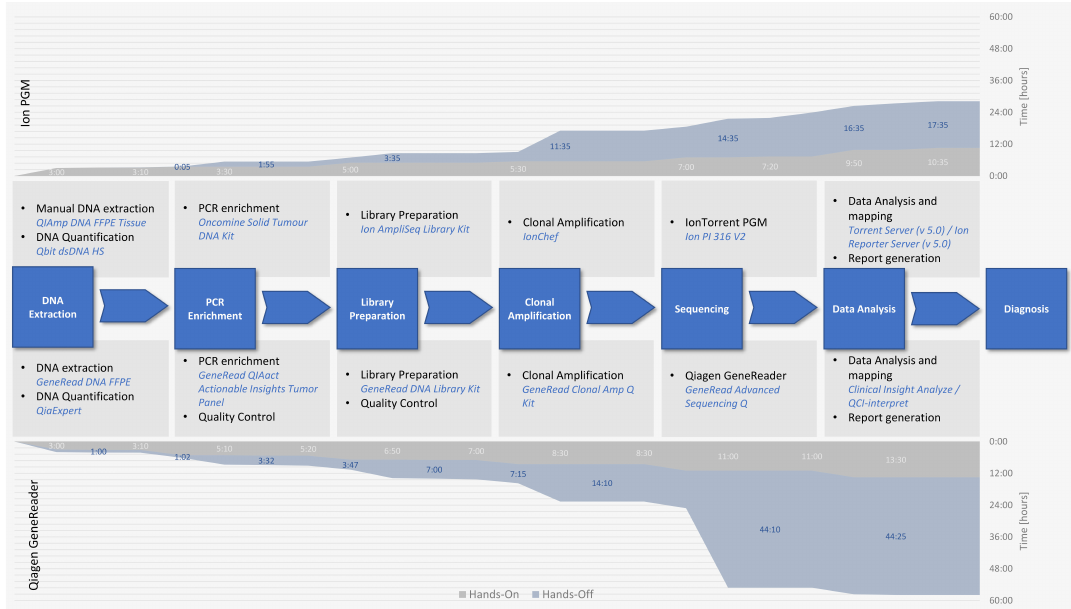
Figure 2. Comparison of the workflow and the different times needed for the Ion PGM workflow in contrast to the GeneReader platform. The central graph shows comparison of the different steps needed from nucleic acid extraction to diagnosis as well as required chemicals and equipment depicted in blue. Hands-on time (grey) is considerably lower for the Ion PGM (upper graph) than for the GeneReader system (lower graph). The time required is indicated in hours:minutes and highlighted in light grey. Concerning the time needed by the different devices (marked in blue), the Ion system was substantially faster than the GeneReader (marked in dark blue on the respective graphs). Therefore, the total time from start to diagnosis is longer for the GeneReader system compared to the Ion PGM (total time is indicated on the Y -axis on the right-hand side of each